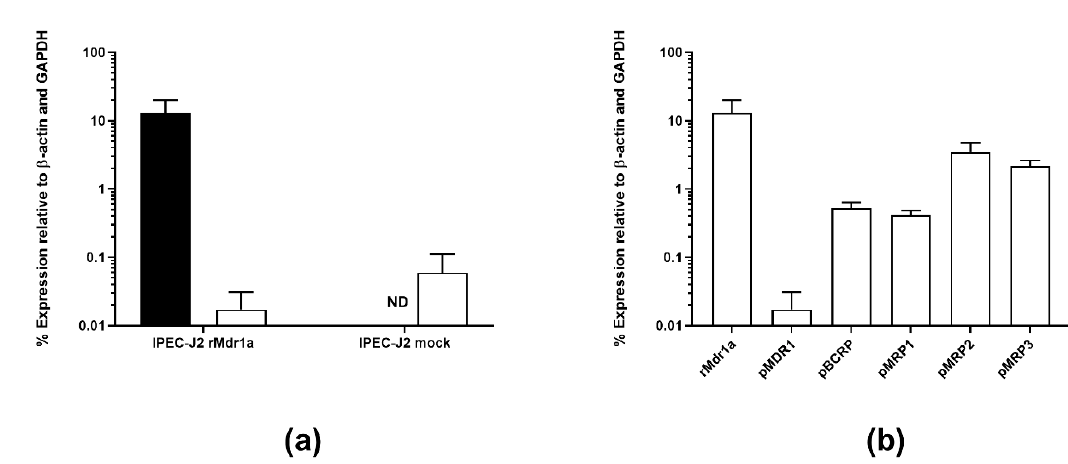
Figure 3. Transporter mRNA expression levels of rat multidrug resistance gene 1a (rMdr1a) and different endogenous porcine efflux transporters in IPEC-J2 cell monolayers. ( a ) Real-time polymerase chain reaction (PCR) data showing mRNA expression levels of rat Mdr1a (rMdr1a) and porcine MDR1 (pMDR1) in IPEC-J2 rMdr1a and mock cell monolayers, quantified relative to β -actin and glyceraldehyde-3-phosphate (GAPDH) expression. Filled bars show expression levels of rat Mdr1a mRNA and open bars show expression levels of porcine MDR1 mRNA. ( b ) Real-time PCR data showing mRNA expression levels of rat Mdr1a (rMdr1a), porcine MDR1 (pMDR1), porcine breast cancer resistance protein (pBCRP), porcine multidrug resistance-associated protein 1 (pMRP1), porcine multidrug resistance-associated protein 2 (pMRP2) and porcine multidrug resistance-associated protein 3 (pMRP3) in IPEC-J2 rMdr1a cells, quantified relative to β -actin and glyceraldehyde-3-phosphate (GAPDH) expression. Bars represent mean values ± SEM from 3 experiments with 3 individual samples per primer-set within each experiment ( n = 3, total N = 9).